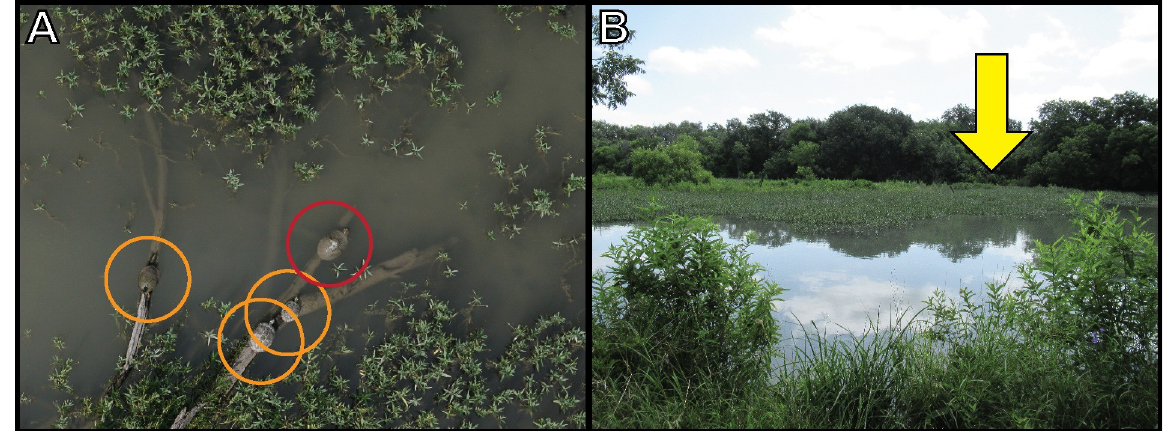
Fig 5. Comparison of aerial and shoreline viewpoint. (A) Drone imagery was able to detect three Pseudemys gorzugi (orange circles) and one Trachemys scripta elegans (red circle) basking on a log at Fort Clark Springs, Las Moras Creek, Buzzard Roost, Kinney County that were not visible from shore; (B) View of the site from shoreline with the log and turtles (yellow arrow) obscured by emergent vegetation.